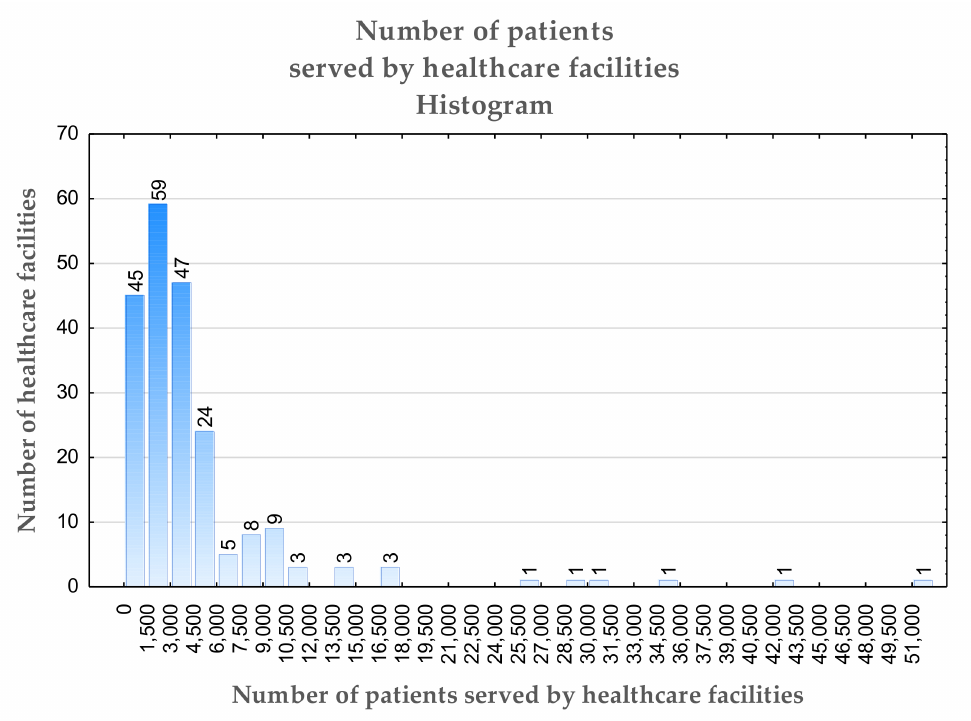
Figure 1. The number of patients served monthly by primary healthcare facilities.